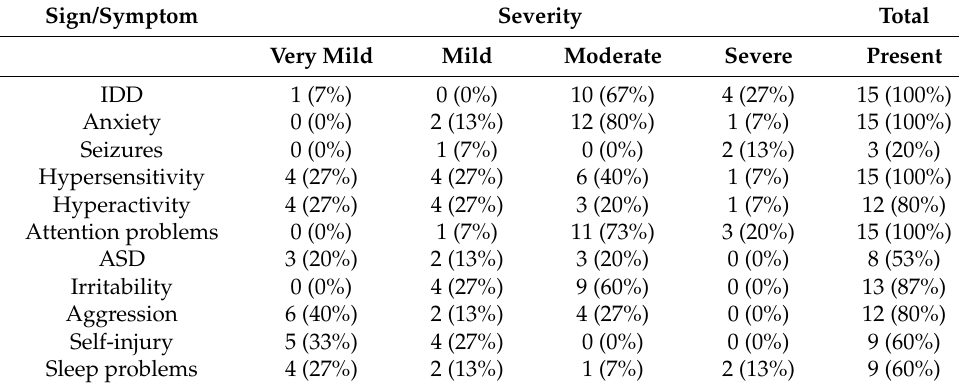
Table 2. Severity of signs and symptoms experienced by individuals with FXS who were using CBD ( n =